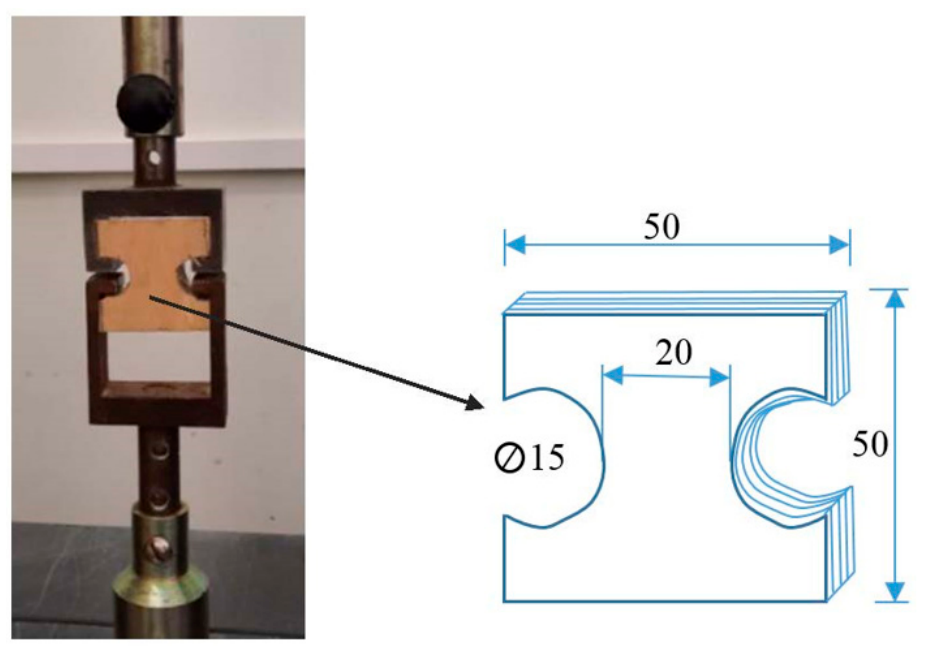
Figure 4. Tensile test specimen and the setup of the experiment, dimensions in mm. The tensile strength and the breakage nature of the specimens (in terms of delamina- tion) were determined during the test. All study results were statistically processed to be able to calculate the standard deviation and the variation